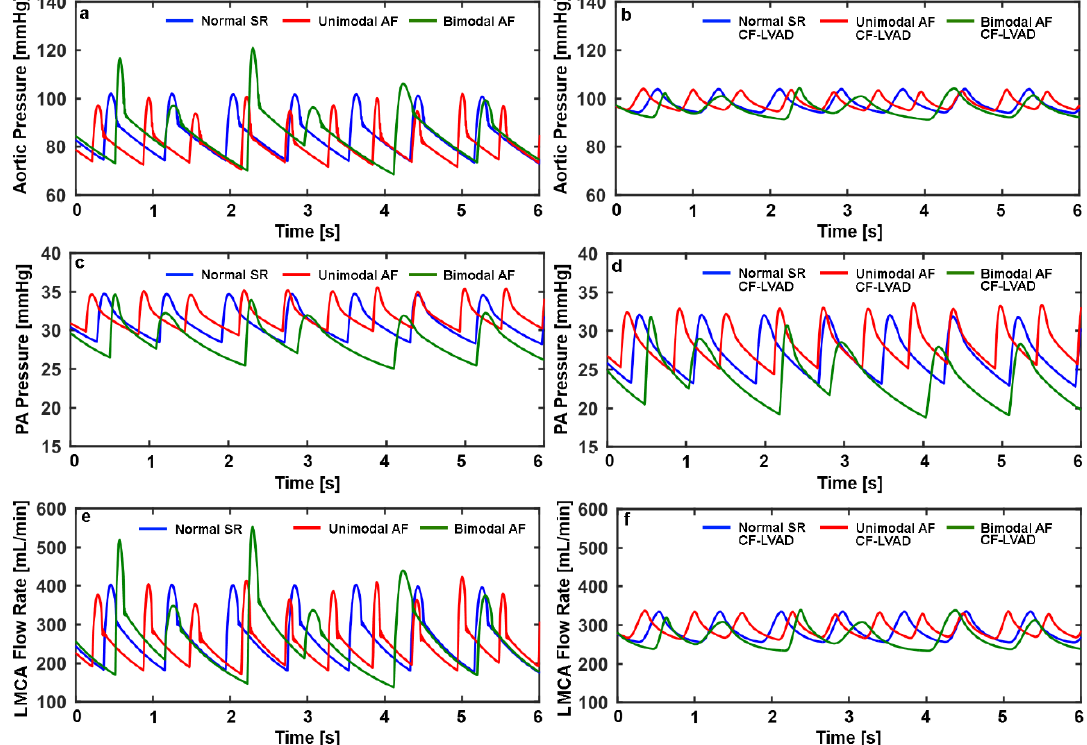
Figure 5. ( a ) Aortic pressures for heart failure during normal sinus rhythm (SR) and atrial fibrillation (AF) with unimodal and bimodal RR interval distributions; ( b ) aortic pressures for CF-LVAD support during normal SR and AF with unimodal and bimodal RR interval distributions; ( c ) pulmonary arterial (PA) pressures for heart failure during normal SR and AF with unimodal and bimodal RR interval distributions; ( d ) PA pressures for CF-LVAD support during normal SR and AF with unimodal and bimodal RR interval distributions; ( e ) left middle cerebral arterial (LMCA) flow rates for heart failure during normal SR and AF with unimodal and bimodal RR interval distributions; ( f ) LMCA flow rates for CF-LVAD support during normal SR and AF with unimodal and bimodal RR interval distributions.